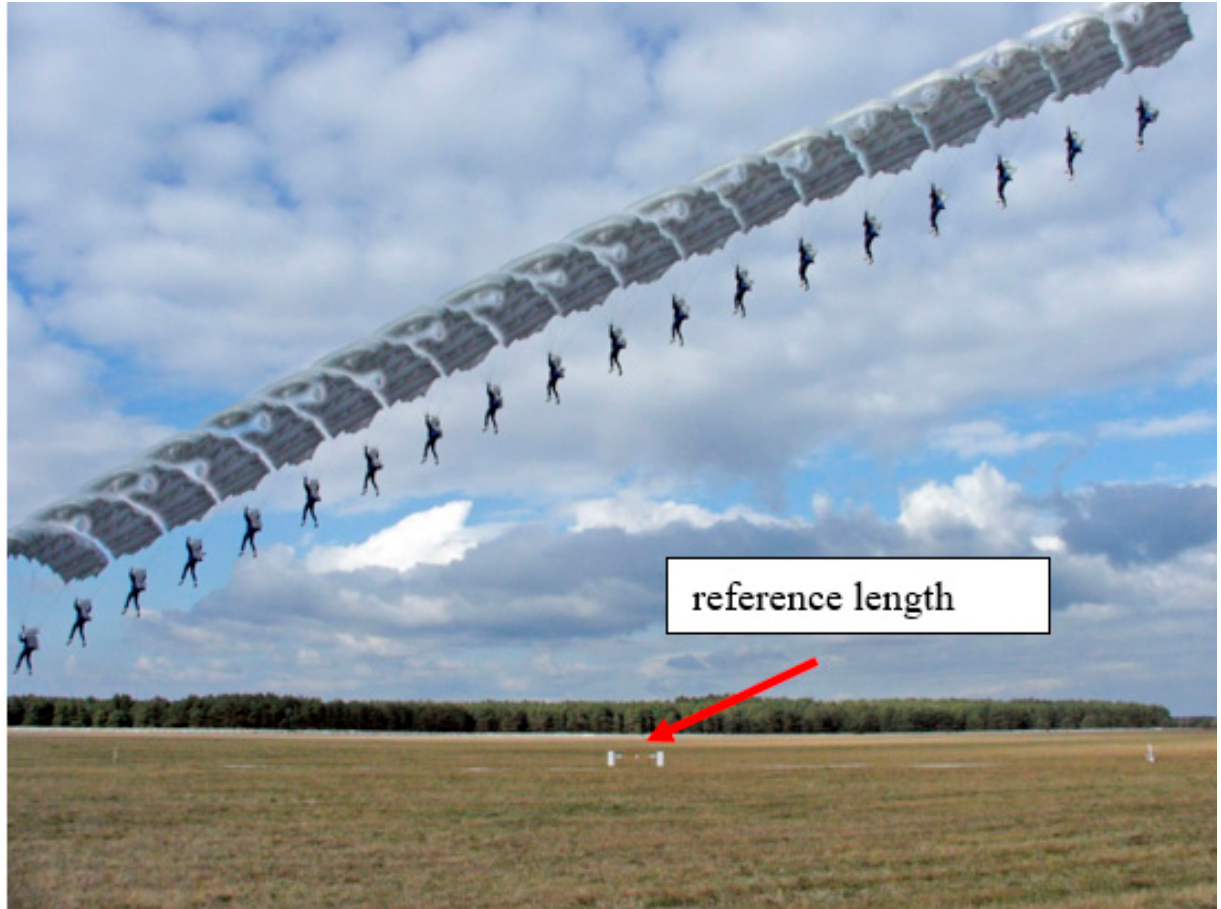
Figure 2. Photomontage from the measurement of the parachute vertical speed using the photo-optical method (source: The authors of this article).